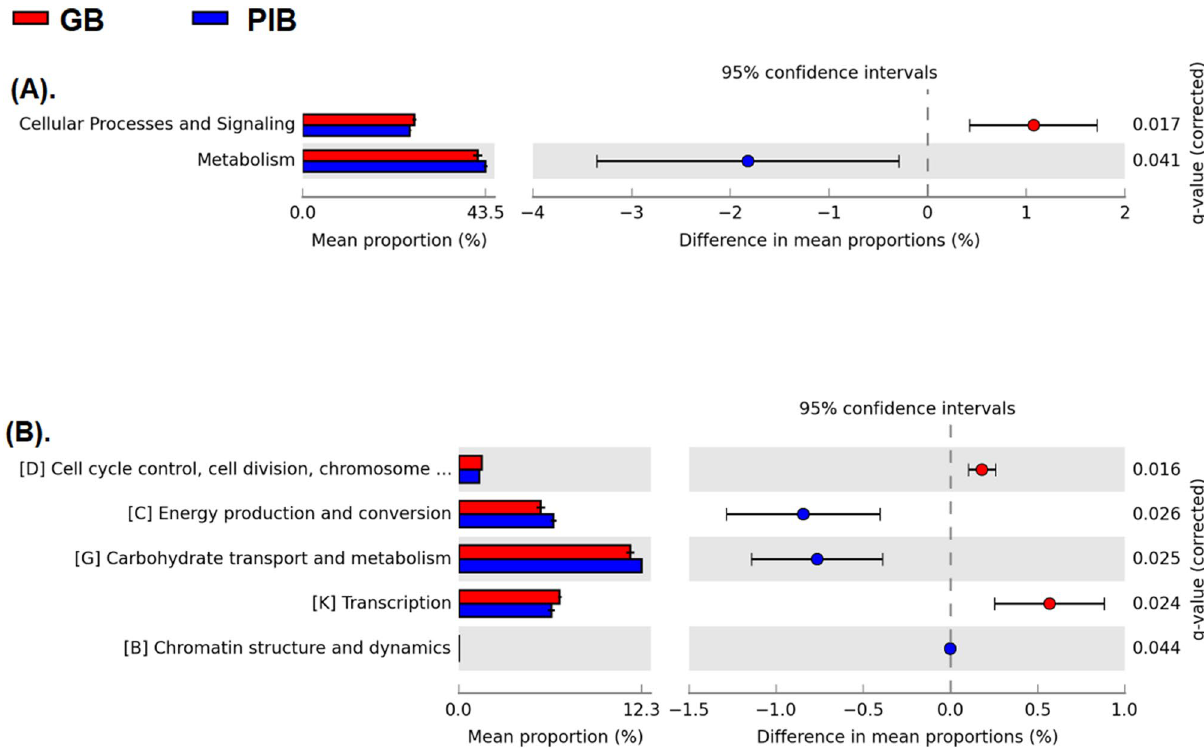
Figure 4. Extended error bar plot at the functional level 1 and level 2 according to the EggNOG functional